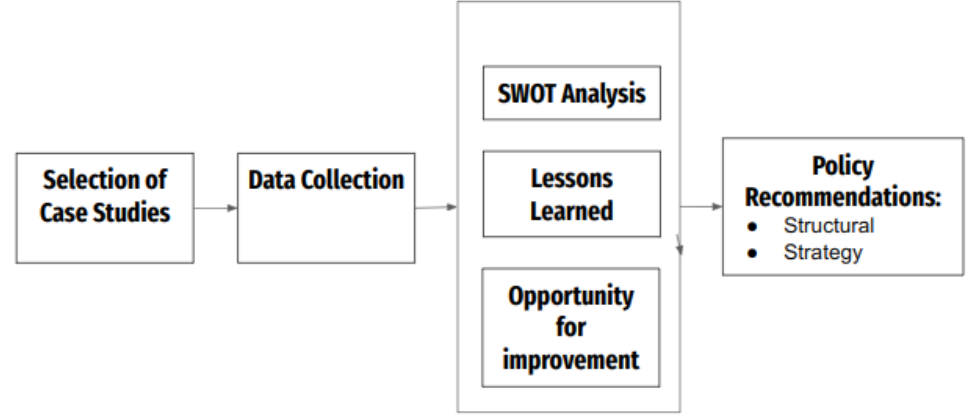
Figure 2. Methodological steps and methods.